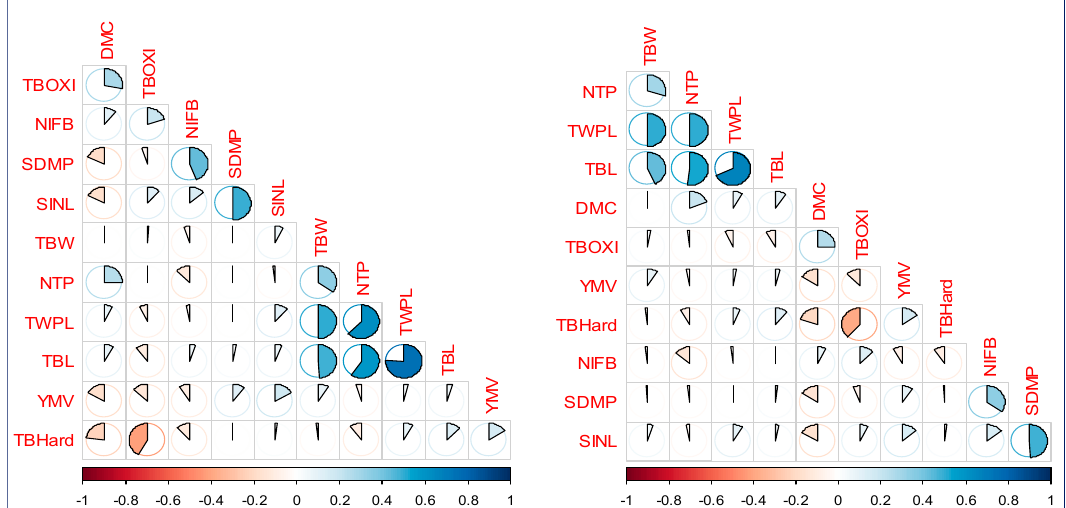
Figure 1. PCA scree plot ( left ) and plot showing the total contribution of variables accounting for the variability in PC1 and PC2 ( right ). TWPL: tuber weight per plant; NTP: number of tubers per plant; TBL: tuber length; TBW: tuber width; SDMP: stem diameter per plant; NIFB: number of internodes before first branching; SINL: stem internode length; YMV: yam mosaic virus; DMC: dry matter content; TBOXI: tuber flesh oxidation; TBHard: tuber flesh hardness.